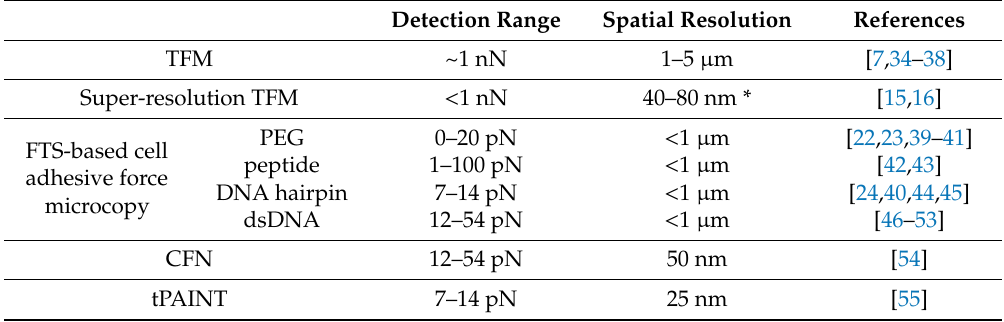
Table 1. Force detection ranges and spatial resolutions of cell adhesive force